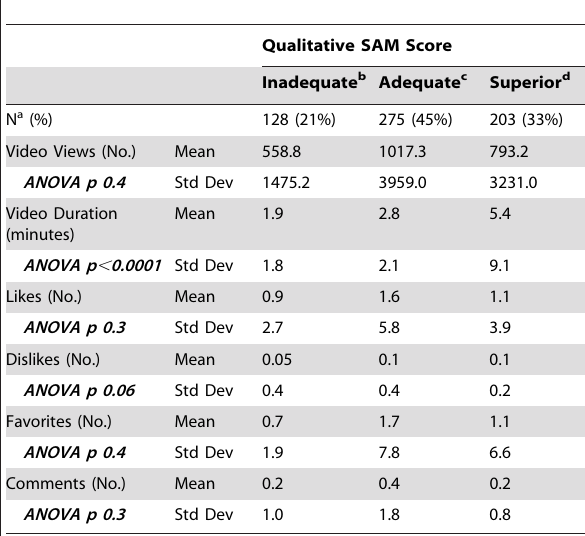
Table 3. SAM scores based on user engagement metrics and video duration.